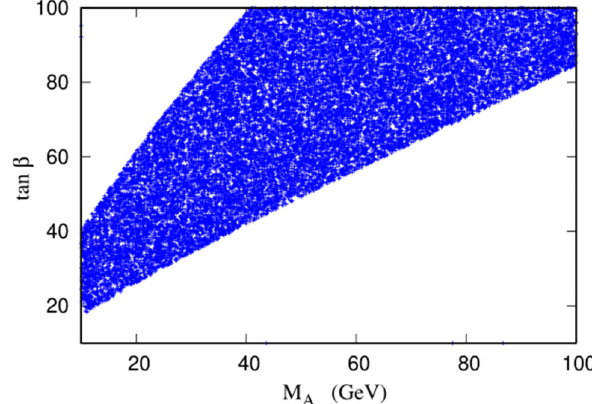
Fig. 1 The allowed region in m A − tan β plane from g μ − 2 data at 3 σ . The flavor changing couplings are taken to be y μ e = 10 − 7 , y τ e = 4 × 10 − 5 , y μτ = 4 × 10 − 5 . The non-standard neutral CP-even Higgs mass is 450 GeV and charged Higgs mass is 460